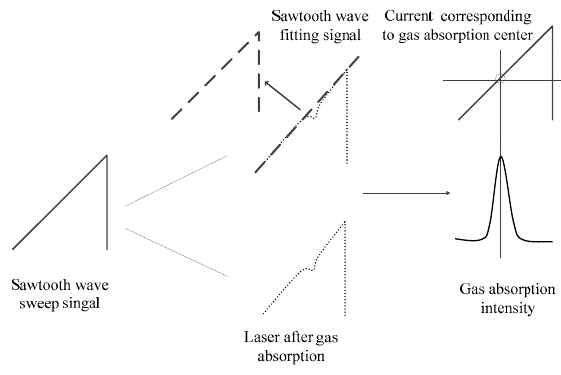
Fig. 1 Gas absorption center-based wavelength calibration